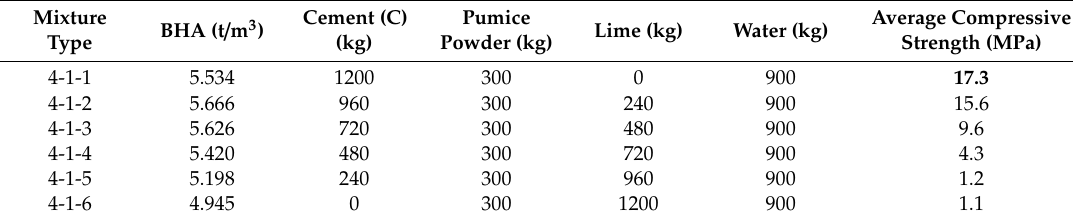
Table 25. Type-1 mixture quantity, weight per unit of volume and compression test